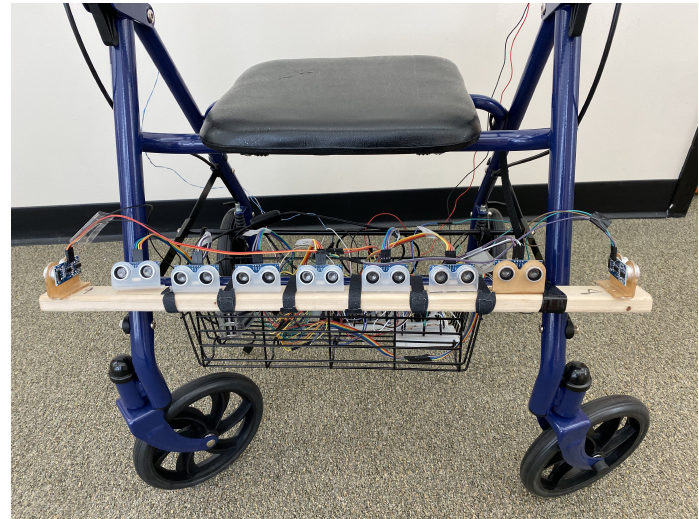
Figure 1. The rollator configured with nine HC-SR04 ultrasonic sensors. Seven sensors are facing forward to capture obstacles in a wide area in front of the walker. To facilitate navigational guidance, two sensors (one on the left and the other on the right) are capturing